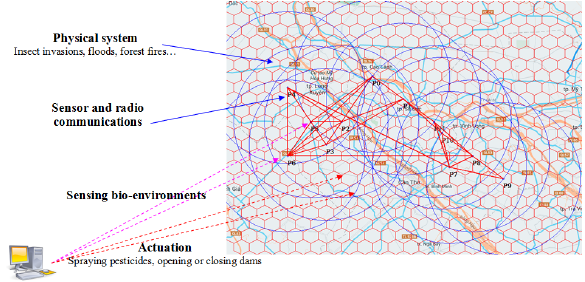
Figure 2. A bio-environmentalsurveillancenetworkis composed of 2 systems.A physicalsystemis a phenomena’s workingspace whichis dividedas cells. These cells are monitoredby a WSN system( sensor and radio communications ).